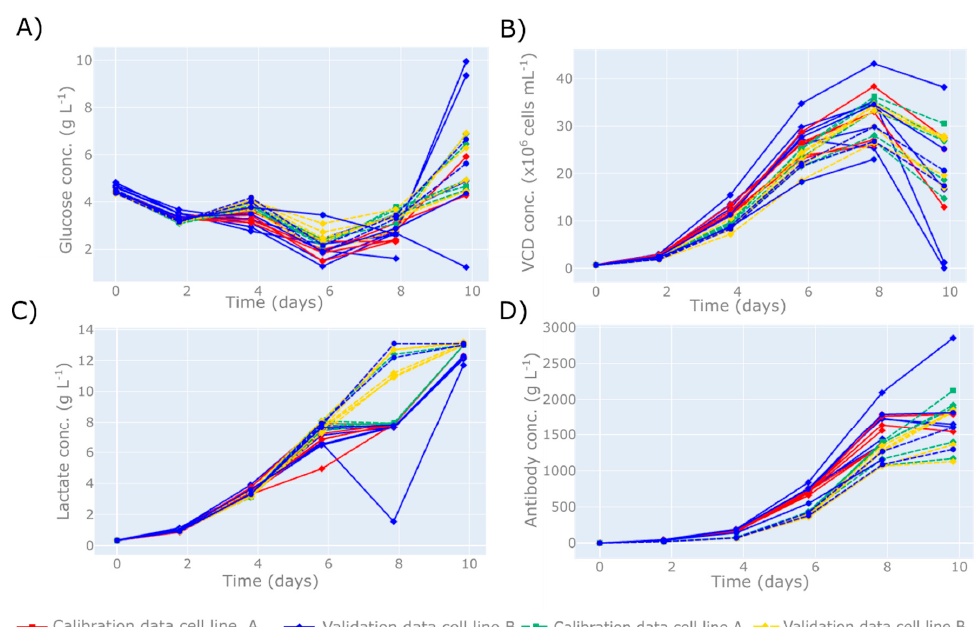
Figure 2. Time series plots of off-line analytics recorded on a micro-bioreactor system for ( A ) glucose concentration, ( B ) viable cell density (VCD) concentration, ( C ) lactate concentration, and ( D ) antibody concentration. Cell line A is indicated by the solid lines with the red lines and squares representing the calibration cell cultures: 1–5 and 7–11. The validation runs are indicated by the blue lines with diamonds, and represent cell cultures 6 and 12. Cell line B is indicated by the dashed lines with the green lines and squares representing the calibration cell cultures: 13–17 and 19–23. The validation runs are indicated by the yellow lines with diamonds and represent cell cultures 18 and 24. The micro-bioreactor system had 24 parallel bioreactors with an initial working volume of 13.5 mL, operated using a pH set-point of 7, DO 2 concentrations of between 10–40%, and a temperature maintained at 35.5 °C.